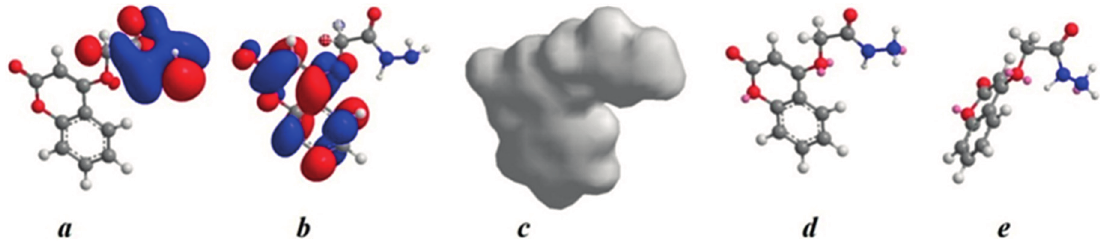
Figure 9. Electronic properties of EFCI ( a ) HOMO orbital; ( b ) LUMO orbital; ( c ) total electron density; ( d ) Fukui (f − ) function; ( e ) Fukui (f + )